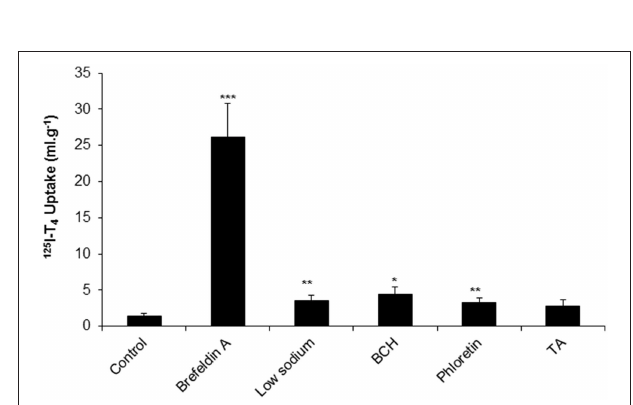
FIGURE 2 | The uptake of 125 I-labeled T 4 into choroid plexus (CP) of rabbits in the presence of brefeldin A, low sodium, BCH, phloretin, and TA. Data is presented as the mean and error bars represent SEM. Asterisks indicate statistical significance using student’s t -test between treatment and control for the indicated brain region, * indicates p < 0.05 , ** p < 0.01 , *** p < 0.001 . n = 5 for control, n = 3 for each